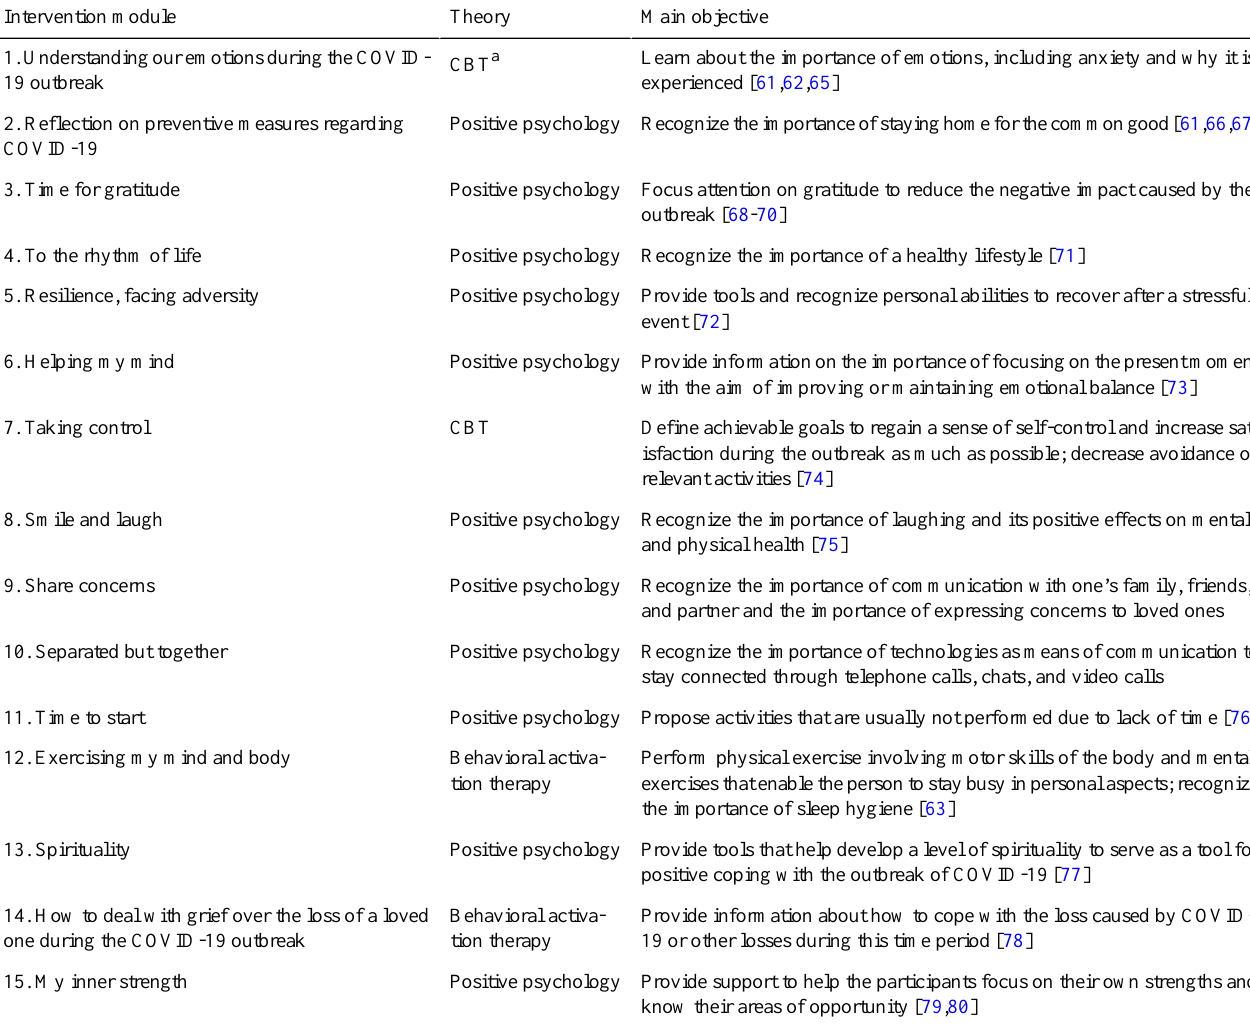
Table 1. Module objectives of the web-based Mental Health COVID-19 intervention.